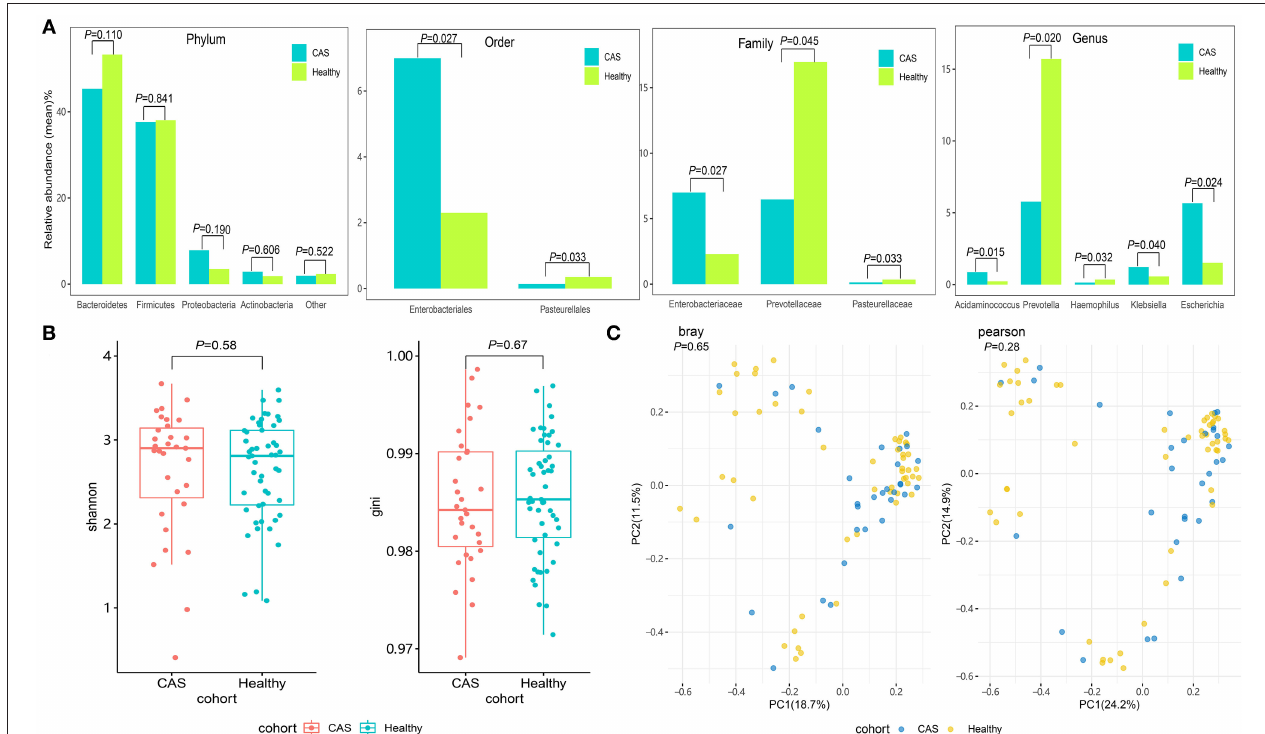
FIGURE 2 | Comparison of the microbial community. (A) The abundant phyla, orders, families, and genera of the gut microbiota between the carotid arteriosclerosis (CAS) and healthy control groups. (B) Comparisons of alpha diversity as determined by the Shannon and Gini indices between the CAS and control groups. (C) Comparisons of beta diversity as determined by the Bray and Pearson distances between the CAS and control